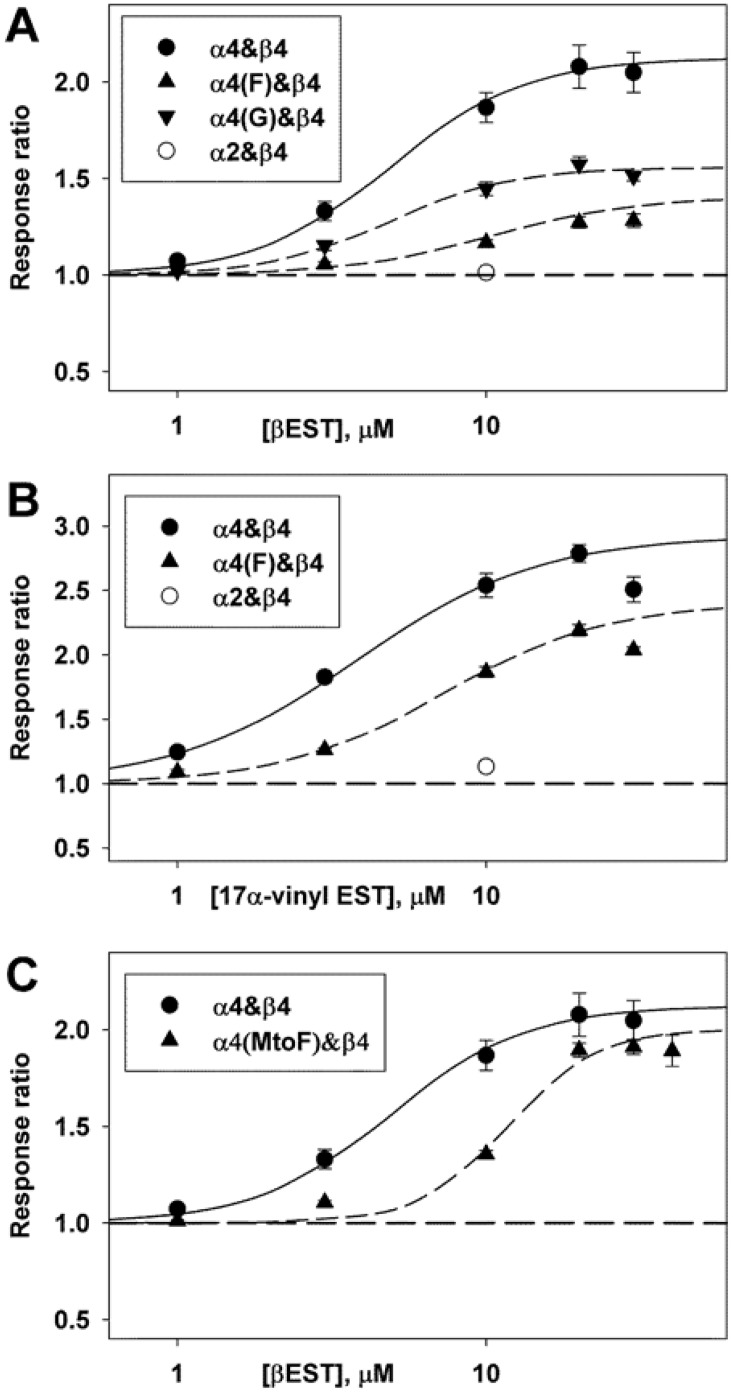
The effects of mutations on the concentration-effect relationship for potentiation.Data are shown for mutations of the tryptophan residue (WLAGMI; panels A and B) and the methionine residue (WLAGMI; panel C). ACh was applied at a concentration producing a response that produced a response of about 5 to 7% of maximal in the absence of steroid. The α subunit was expressed with β4 at an injection ratio of 20:1. The concentration-response relationship for potentiation was characterized by fitting a 3 parameter Hill equation to the ratios (Z[drug] = 1 + Zmax (1 / (1 + (EC50/[drug])^nHill), where Z is the response to a concentration of ACh in the presence of drug relative to that in the absence, Zmax is the maximal effect, EC50 is the concentration producing half-maximal potentiation, and nHill is the Hill coefficient. The fits did not include points that appeared to demonstrate block (e.g. data with 30 μM 17α-vinylestradiol). The data from each cell were fit separately, giving the following mean parameter estimates for βEST: α4: Zmax = 1.12 ± 0.12 (11 cells) and EC50 = 4.92 ± 0.48 μM; for α4(F): 0.41 ± 0.06 (3) P = 0.0002 and 10.43 ± 2.00 μM P = 0.4; for α4(G): 0.56 ± 0.03 (4) P = 0.001 and 4.90 ± 0.38 μM P = 0.98; and for α4(MtoF): 1.00 ± 0.03 (8) P = 0.34 and 11.76 ± 0.39 μM P < 0.0001, with values given as mean ± SE (number of cells) and significance of difference to α4 by t-test. The best-fitting estimates for 17α-vinylestradiol are: α4: 1.93 ± 0.06 (3) and 3.84 ± 0.27 μM and α4(F): 1.41 ± 0.08 (4) P = 0.004 and 7.32 ± 0.68 μM P = 0.010. The points show mean ± SE while the lines show the relationship predicted by the mean fit parameters.